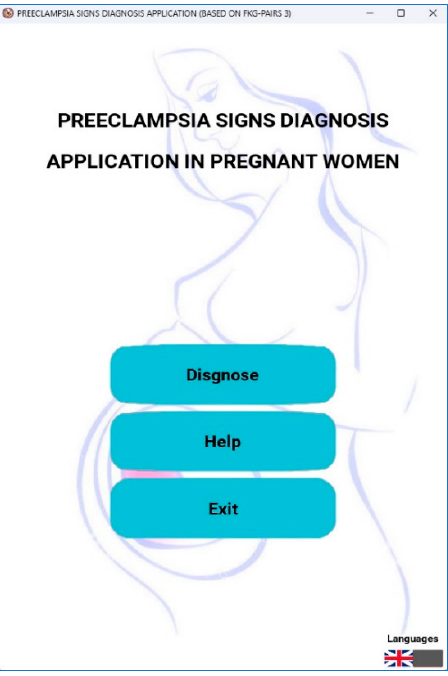
Figure 5. The main screen of the application.